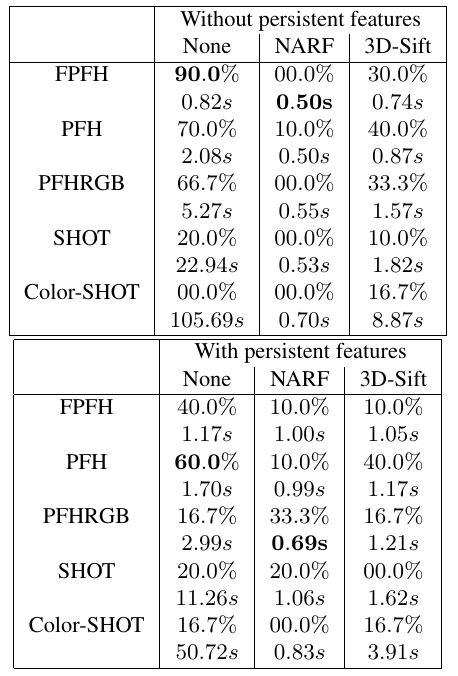
Table 2: Runtime and subjective results (10 ICP iterations) Without persistent features